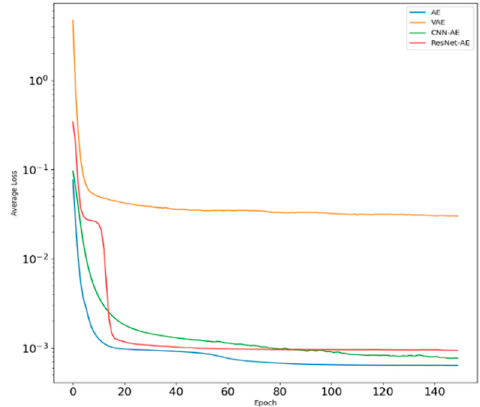
Figure 5. Variation of training loss of several models.